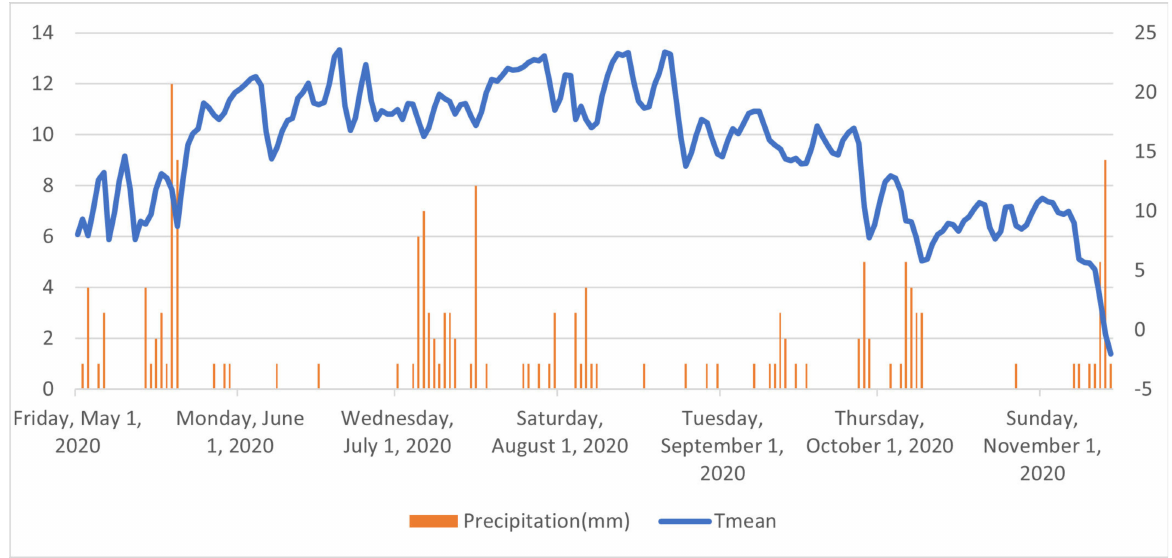
Figure 1. Precipitation and temperature during the growing season. Table 1. Physical and chemical properties of experiment soil from a depth of 0–50